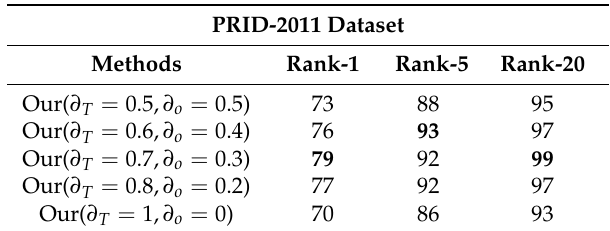
Table 8. Verification experiment results for the different weights with the two-stream architecture on the PRID-2011 dataset in terms of CMC values.